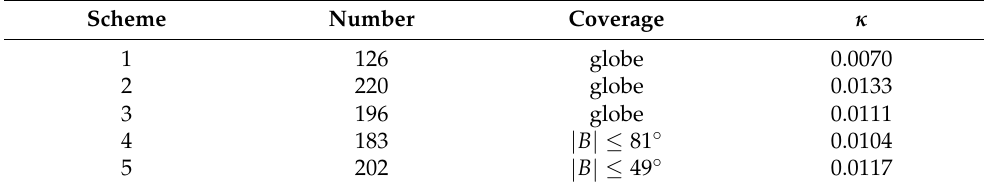
Table 5. The minimum number of designed LEO constellations and their coverage